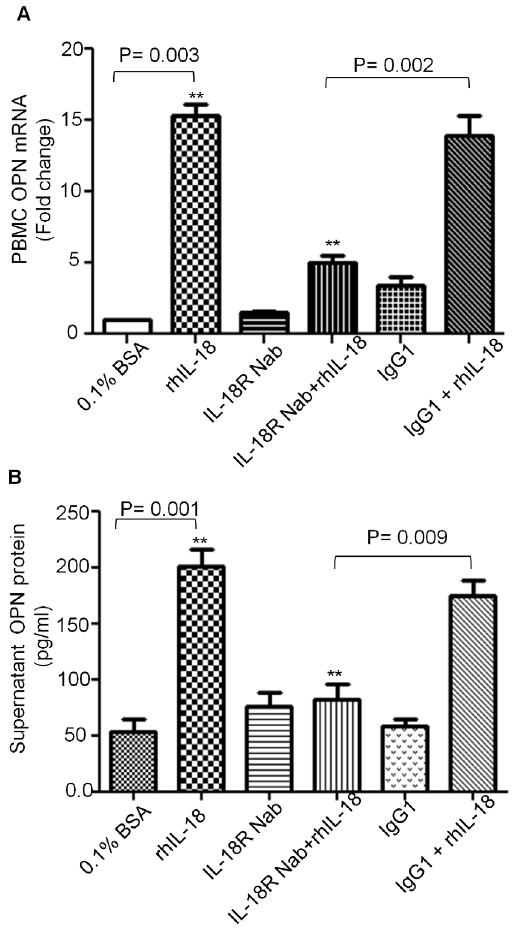
Figure 5. OPN is expressed by PBMCs and its secretion is induced by rhIL-18. PBMCs were treated with and without rhIL-18 (20 ng/ml) in the presence or absence of anti IL-18R a neutralizing monoclonal antibody (0.1 ug/ml), and isotype control antibody IgG1 (0.1 ug/ml). Cells were treated as indicated for 16 hours. PBMCs and culture supernatants were harvested. Total RNA was isolated and OPN gene expression was determined by real time quantitative RT-PCR. Relative mRNA expression was expressed as fold expression over average of gene expression of controls. The average expression level in controls was assumed to be 1. Values are presented as mean 6 SE (A). Secreted OPN protein was determined in the culture supernatants by ELISA (B). Data were shown from three independent experiments, each performed with PBMCs derived from three different healthy donors.